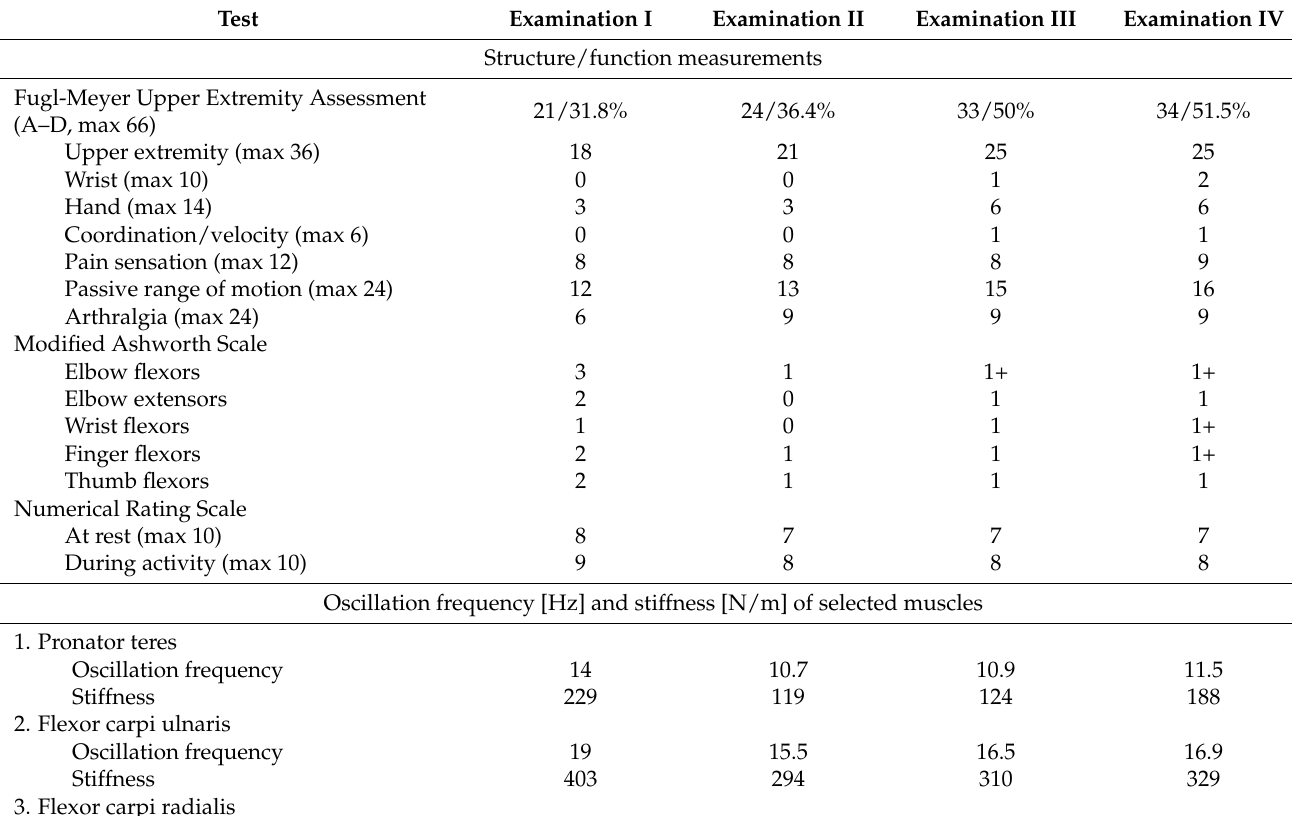
Table 1. Results of structure/function measurements, oscillation frequency and stiffness of selected muscles during examinations I to